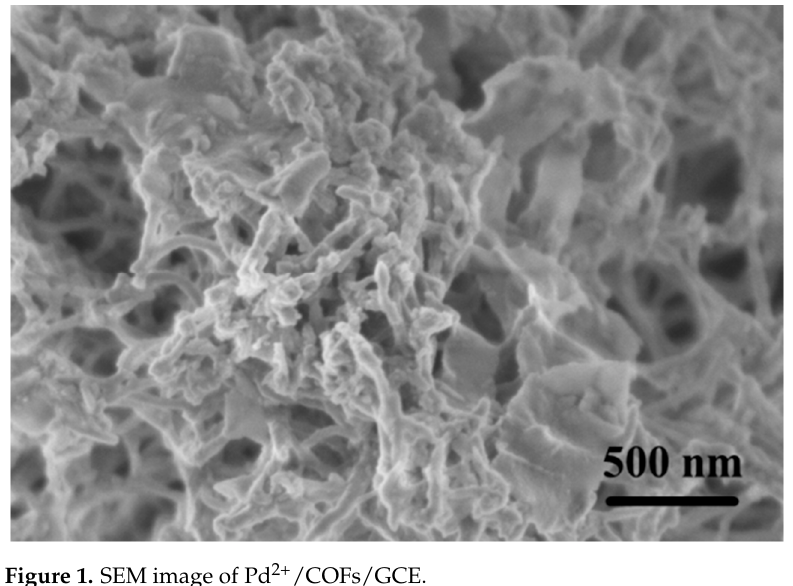
Figure 1. SEM image of Pd 2+ /COFs/GCE.